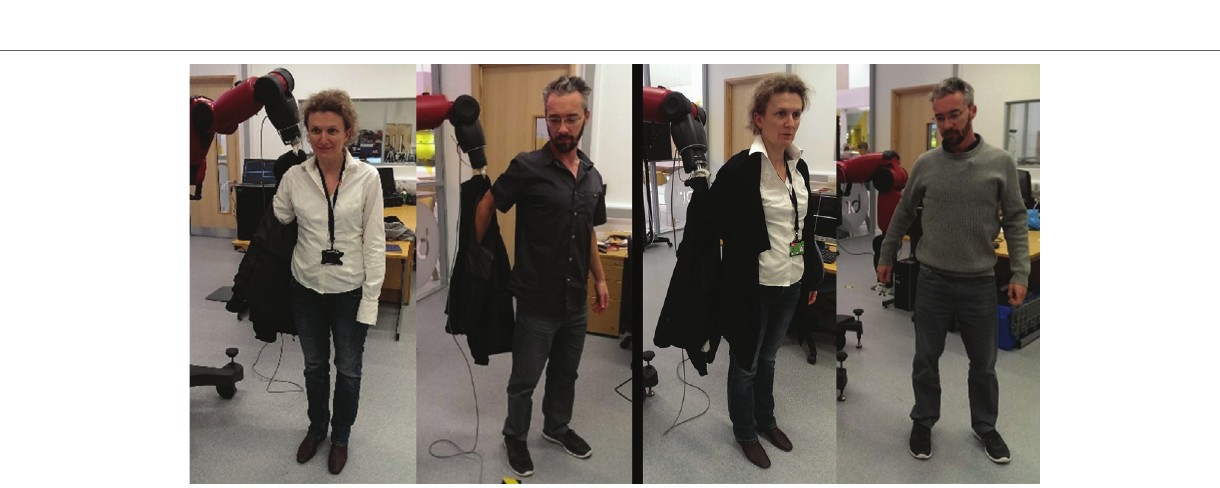
FigUre 5 | showing participant testing for (left) shirt and (right) jumper worn over the top of the shirt .